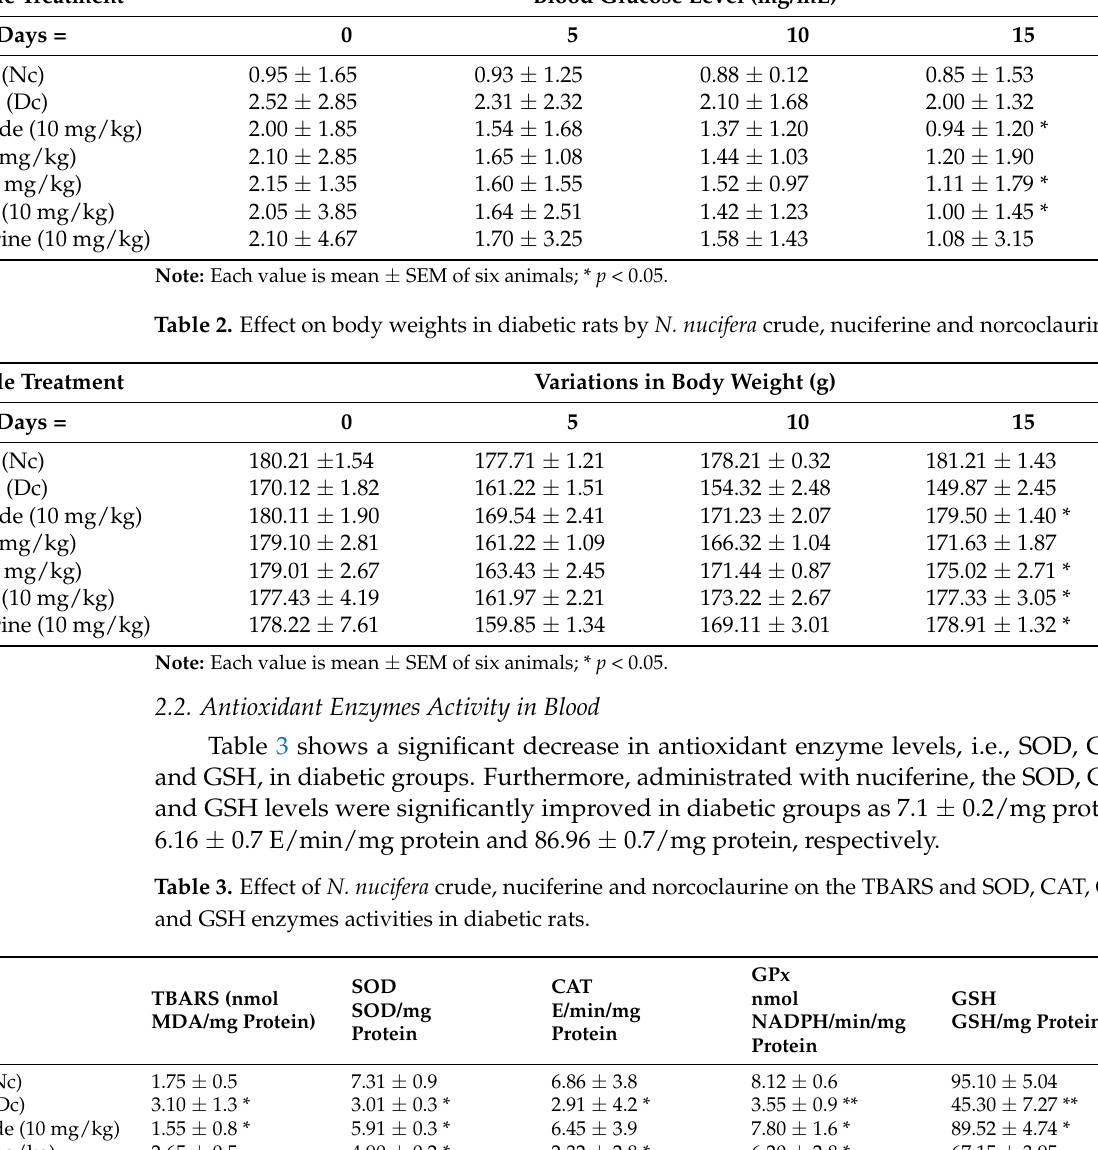
Table 1. Effect on blood glucose levels in diabetic rats by N. nucifera crude, nuciferine and norcoclaurine. Sample Treatment